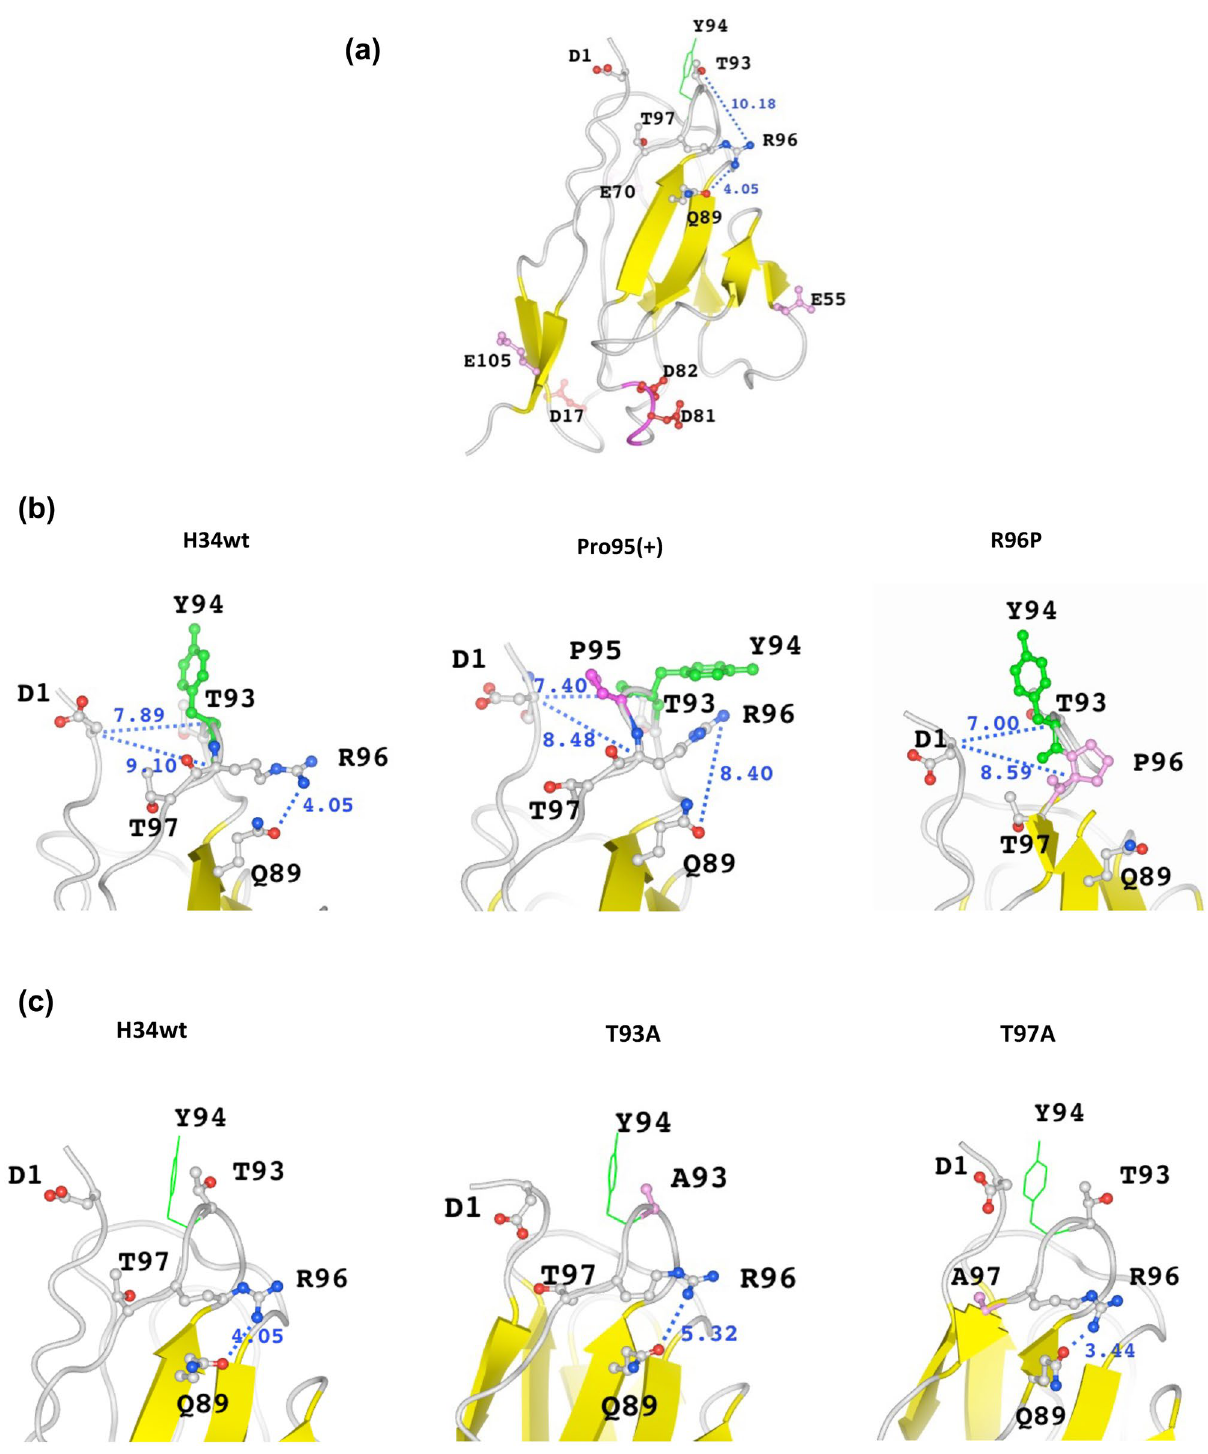
Figure 8. Molecular modeling. Numerical number is the distance between two atoms (Å). ( a ) H34wt: Asp17, Asp81, Asp82, Glu55, Glu70, and Glu105 residues capable of pulling a proton of Arg96 are present in the variable region; however, they are too far to interact with Arg96. The carbonyl of Gln89 residue can interact with the hydrogen of amino group of Arg96. The distance between them is 4.05 Å, which is preferable for interaction. ( b ) Comparison of H34wt, Pro95(+), and R96P: the conformation of Tyr94 residue of H34wt and Pro95(+) is considerably changed from the vertical position in H34wt to the horizontal position in Pro95(+). Additionally, the conformation of Arg96 is considerably altered. The conformational changes between H34wt and R96P are small, except the replacement of the residue. In H34wt, Pro(95+) and R96P, the distances of Cα between D1-T93 and D1-R96 are in the range within 1.0 Å, suggesting small changes in the clones. ( c ) Comparison of H34wt, T93A, and T97A: the conformations of Arg96 are slightly different among the three light chains; however, those of Tyr94 are not considerably changed. The distance between Q89(O)-R96(N) becomes longest (5.32 Å) in T93A among three clones. The β-sheet content appears to increase in the mutants T93A and T97A compared with that in